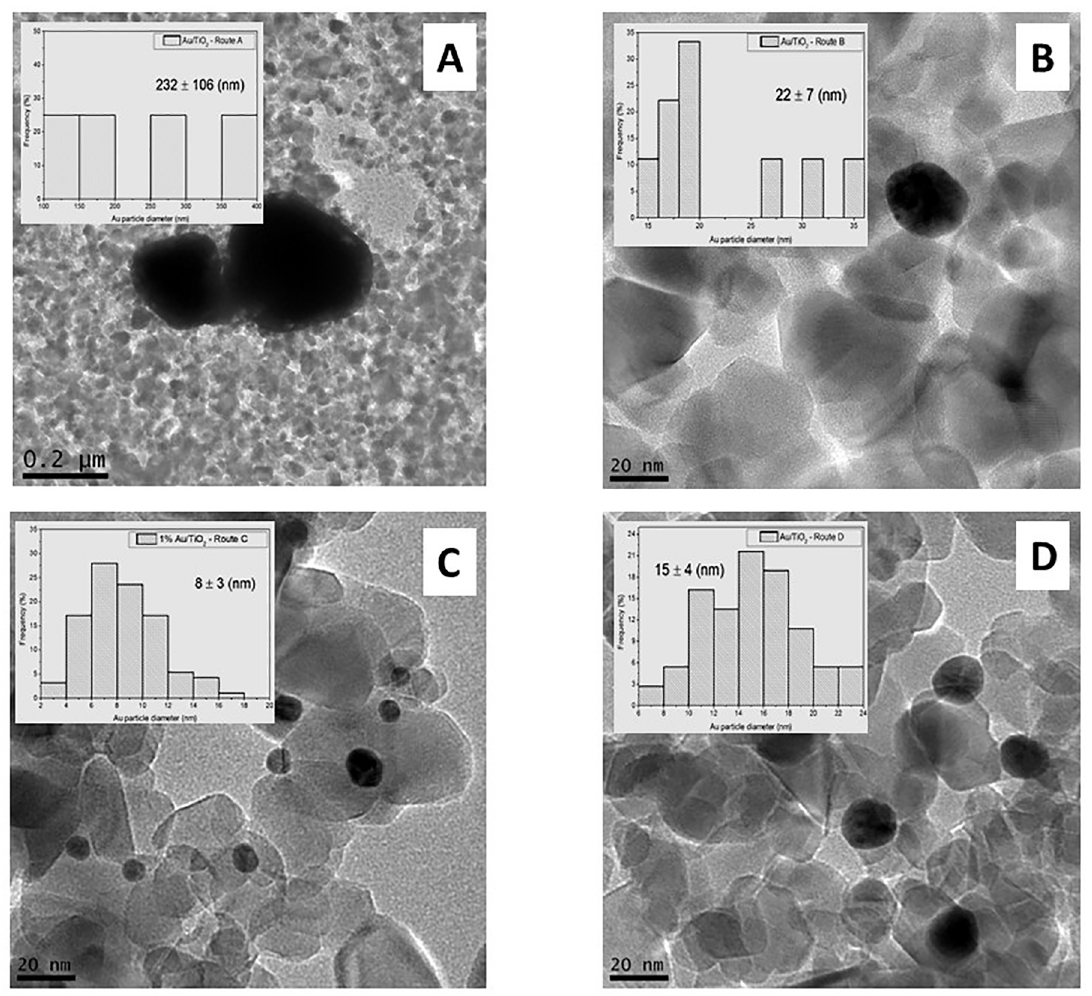
Figure 2. Transmission electron micrographs and histograms of Au/TiO